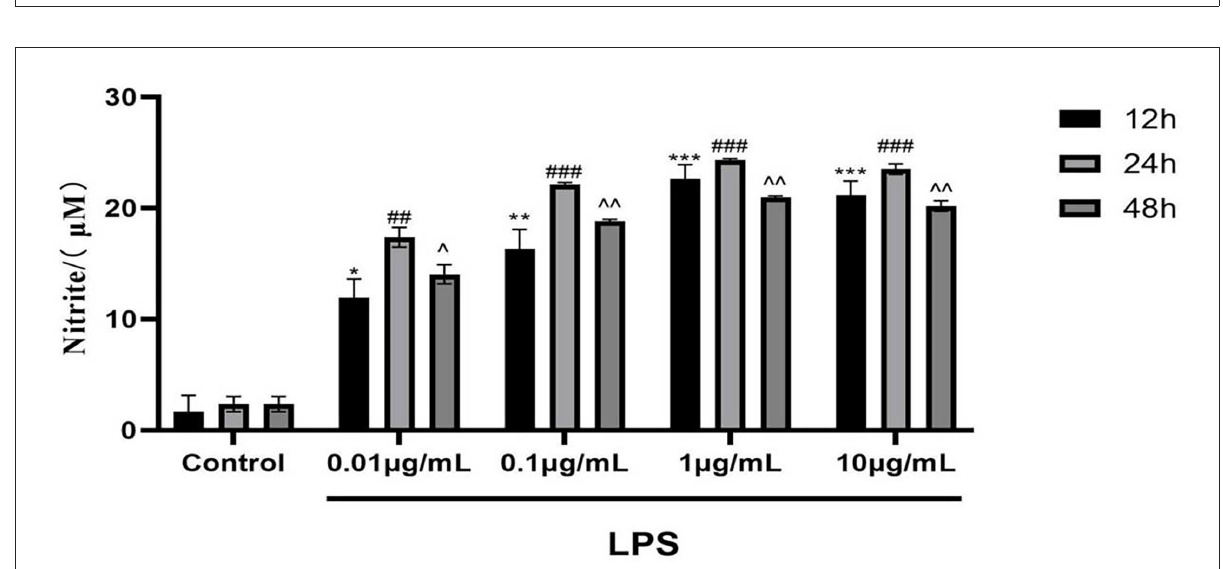
FIGURE8 Effects of different concentrations of LPS for different times on NO production in mouse RAW 264.7 macrophages (Compared with the control group, at 12, 24 and 48h respectively, * P < 0.05, ** P < 0.01, *** P < 0.001; ## P < 0.01, ### P < 0.001; ∧ P < 0.05, ∧∧ P <